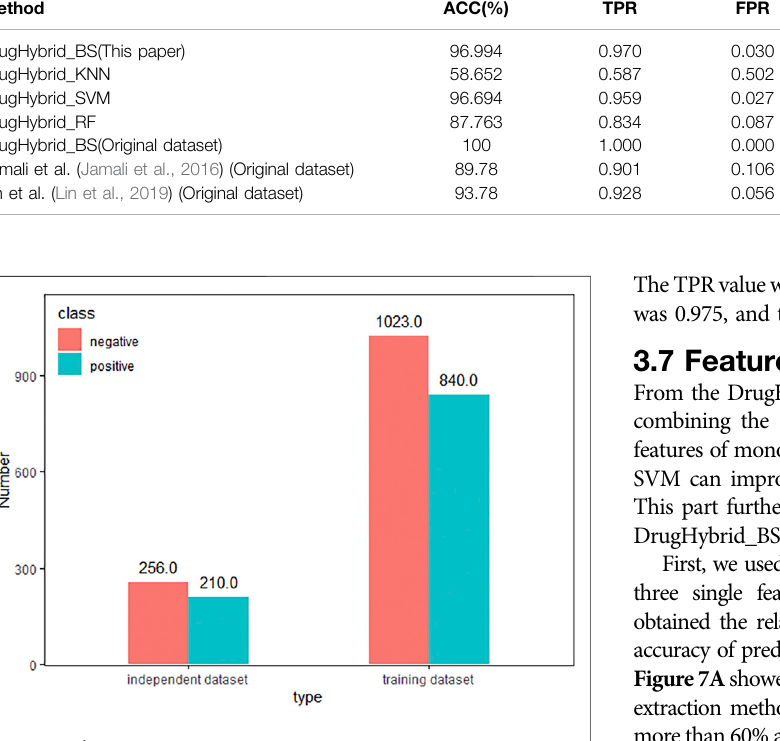
Frontiers in Pharmacology |